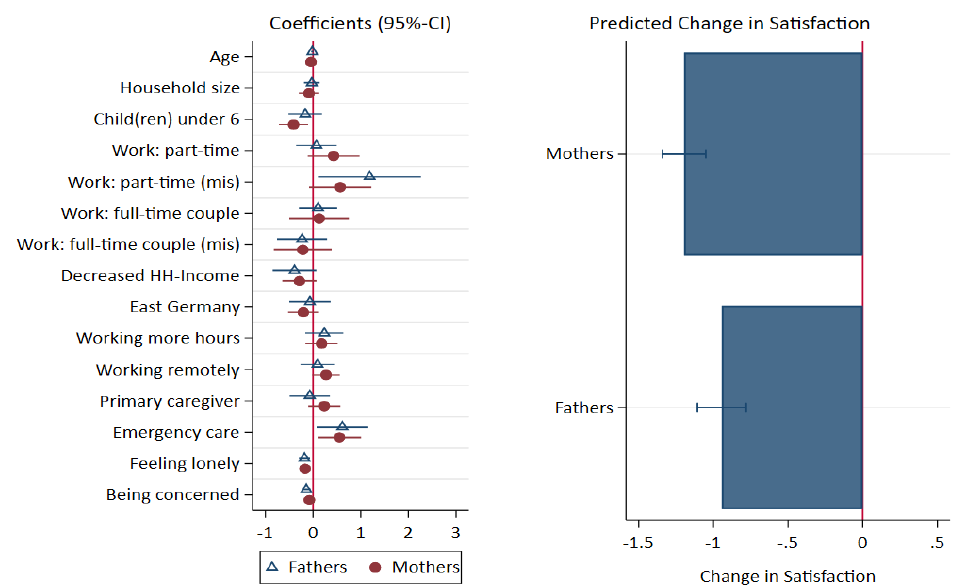
Figure 2: Coefficients and predicted change in satisfaction from separate models for mothers and